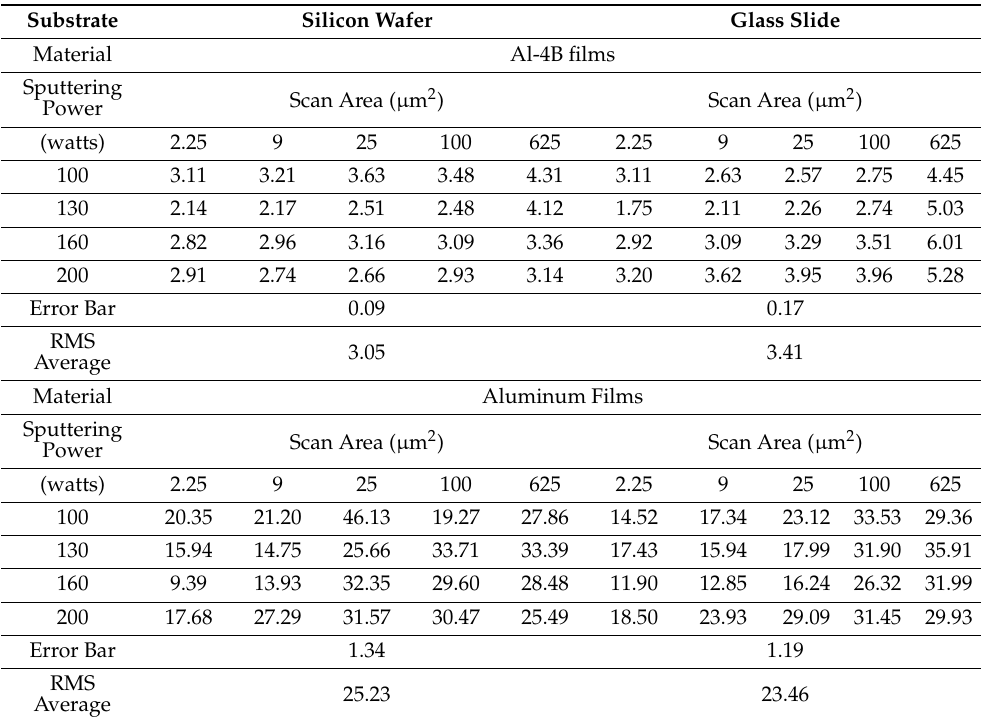
Table 1. RMS roughness summary of Al-4B films and pure aluminum films deposited on silicon wafer and glass slide, for each scan area and sputtering